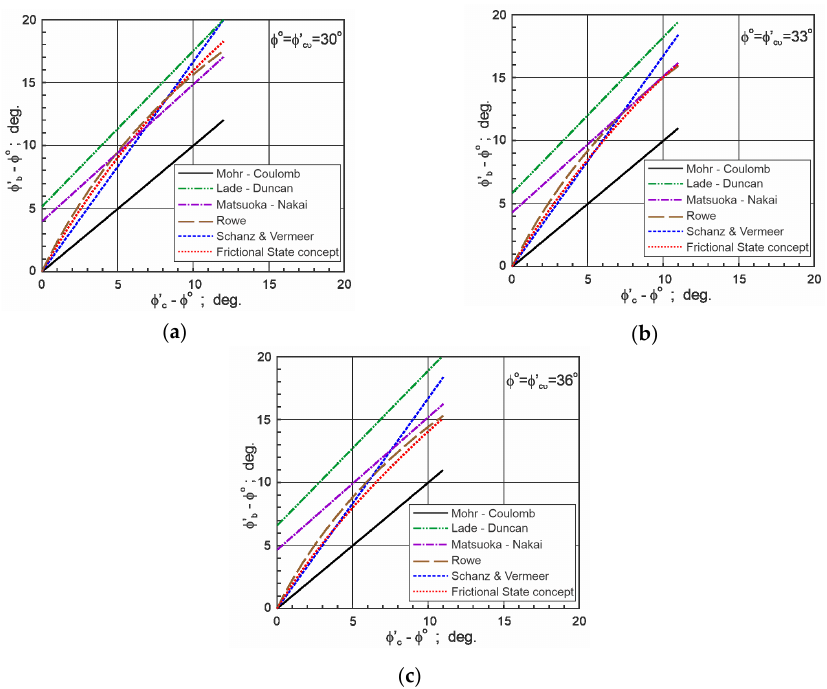
Figure 2. Relationship between the excess of friction angle for biaxial and triaxial compression: ( a ) ◦ = φ (cid:48) = 30 ◦ , ( b ) φ ◦ = φ (cid:48) = 33 ◦ , ( c ) φ ◦ = φ (cid:48) = 36 ◦ φ . c υ c υ c υ